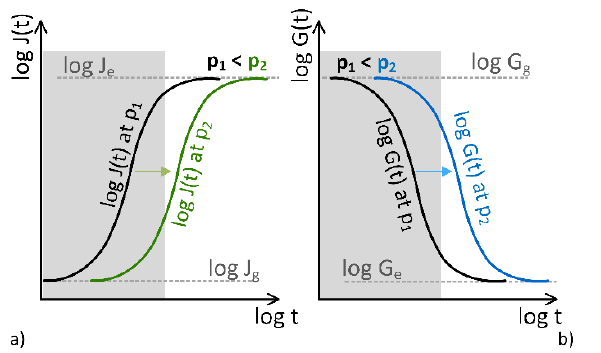
Figure 1. Schematics present behavior of cross-linked elastomers under pressure with a shift of the ( a ) creep compliance and ( b ) the relaxation modulus towards longer times.